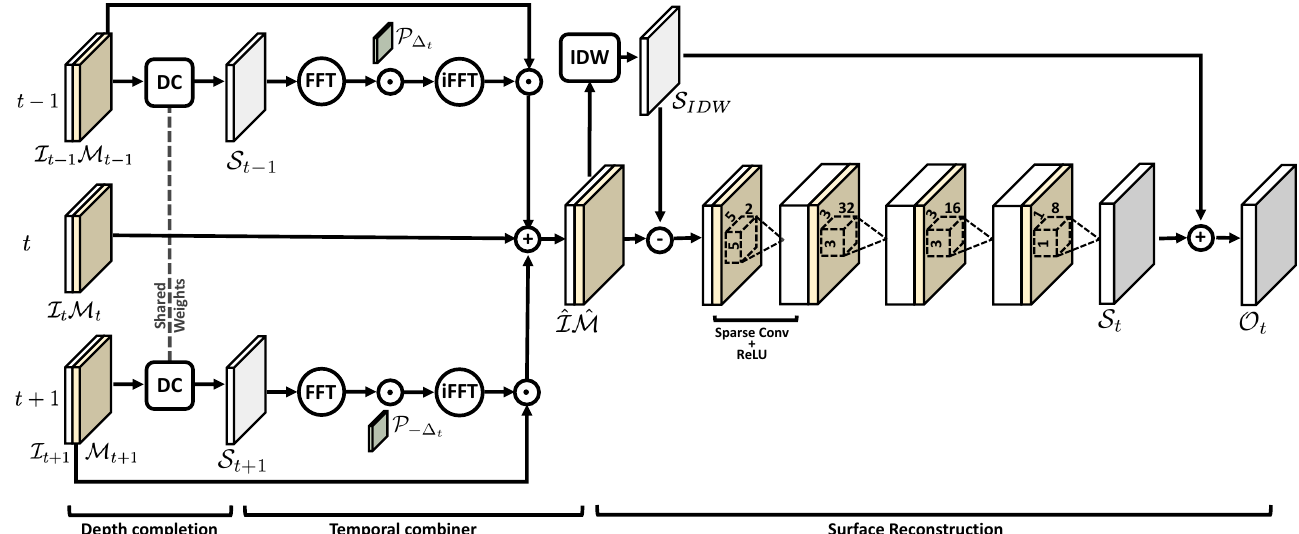
Figure 3. The WASSfast surface reconstruction CNN. Input is composed by 3 frames taken at time ( t − 1 ) , ( t ) and ( t + 1 ) . Each frame is a 2-channel 256 × 256 × 2 tensor containing the sparse elevation data and the validity mask. The phase rotation matrices P ∆ and P ∆ are assumed to be known according to the current sequence frame rate, wave propagation t − 1 t + 1 direction, etc. Frames I t − 1 and I t + 1 are processed in parallel by 2 depth completion blocks with shared weights. Then, the temporal combiner transports the surfaces S t − 1 and S t + 1 to time t . The predicted surfaces are multiplied by their original masks ( M t − 1 , M t + 1 ) and merged with I t , creating new denser data ( ¯ I , ¯ M ) . The result is then processed by the surface reconstruction block to produce the final surface O t